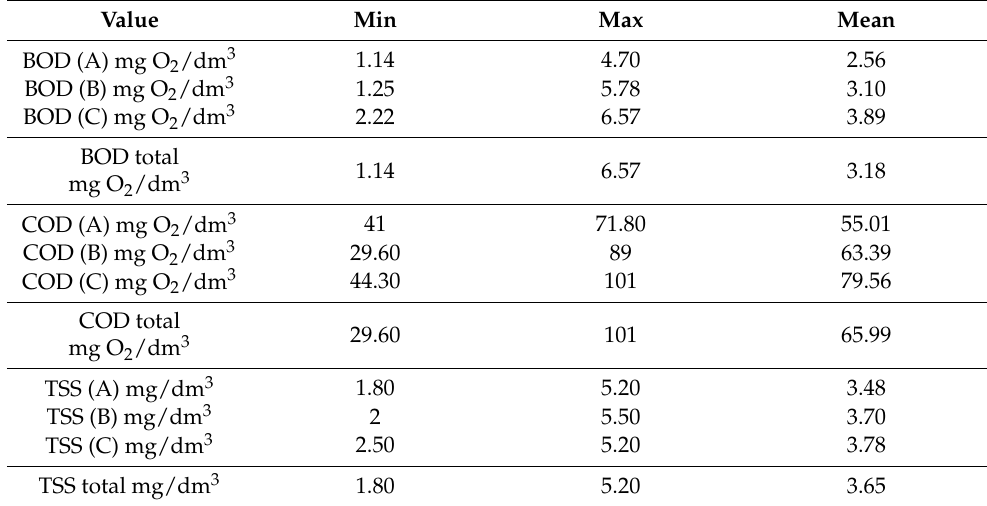
Table 3. Concentration of organic matter and suspended solids after compost beds (sample 1) in the second stage of operation (from October